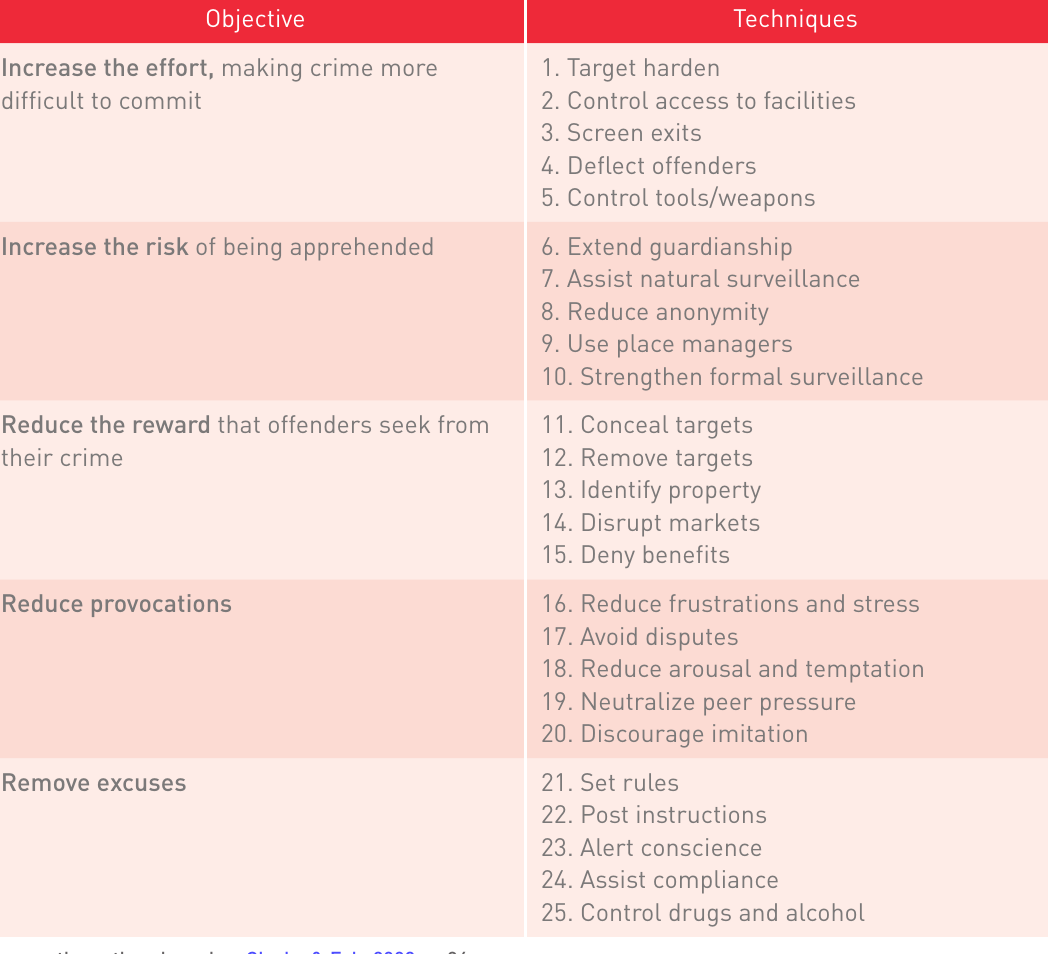
Twenty- five Techniques of Situational Crime Prevention Objective